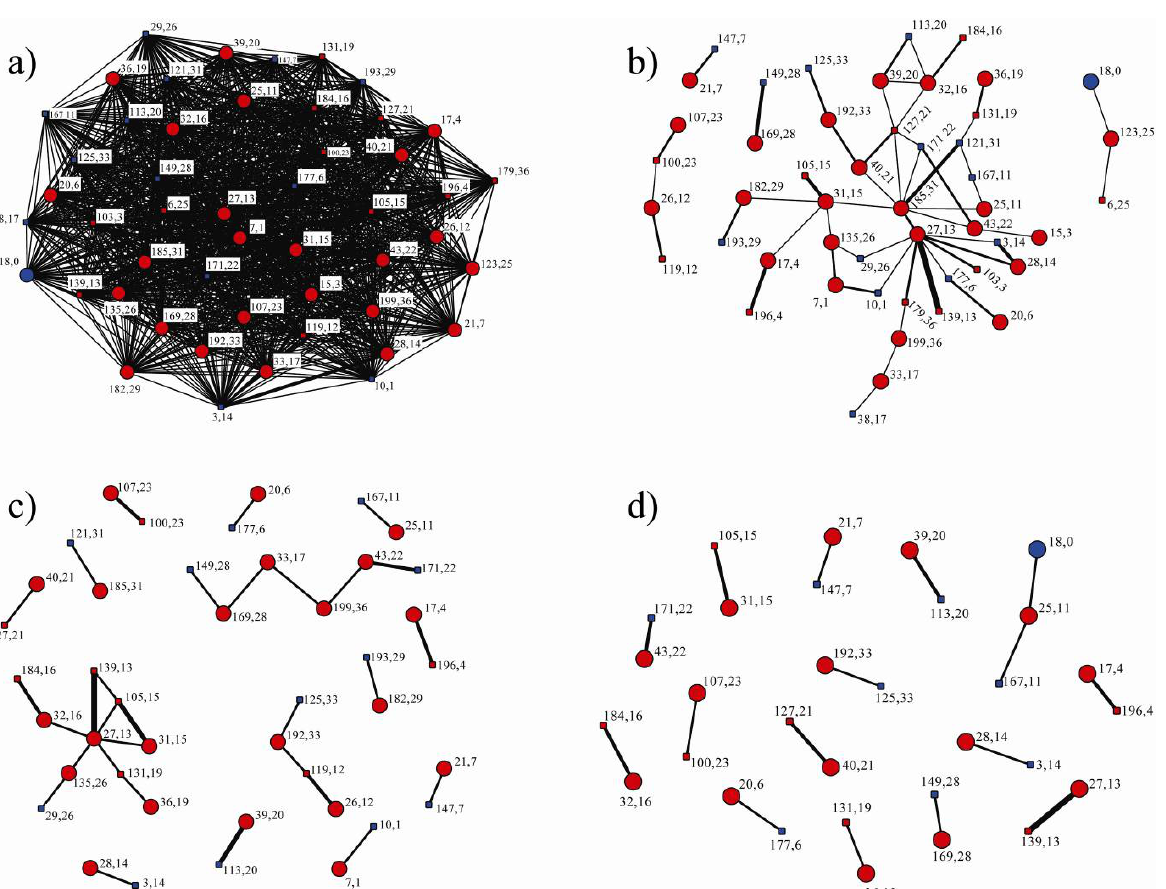
Figure 5. Network diagrams representing total contact duration of contacts less than 5 m between animals logged by proximity loggers. (a) The complete network on day 2, based on 49 animals. (b) The network on day 2 where total contact time was greater than 40 minutes. (c) The network on day 4 where total contact time was greater than 60 minutes. (d) The network on day 6 where contact time was greater than 80 minutes. Isolates (those individuals with no contacts within the specified timeframe) in diagrams (b)-(d) have been removed. Key: colour: red = female, blue = male; shape: circle = adult, square = calf; label: first label is contact logger ID, second label is cow/calf pair code (same pair code equals identified cow/calf pair); thickness of lines represents association